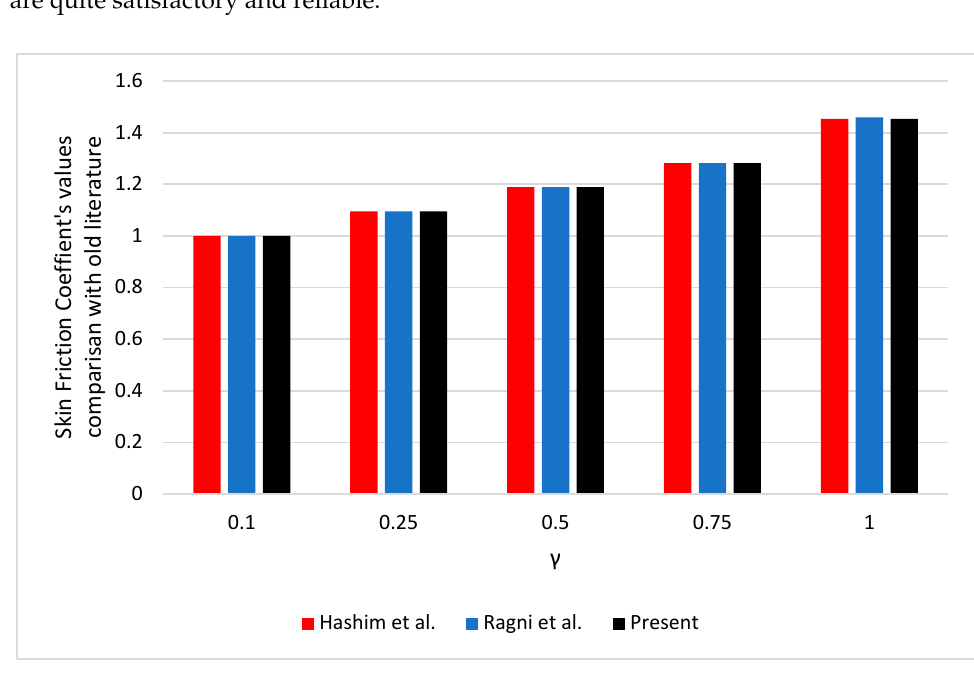
Figure 3. A comparison of skin friction in statistical form with [59,60].